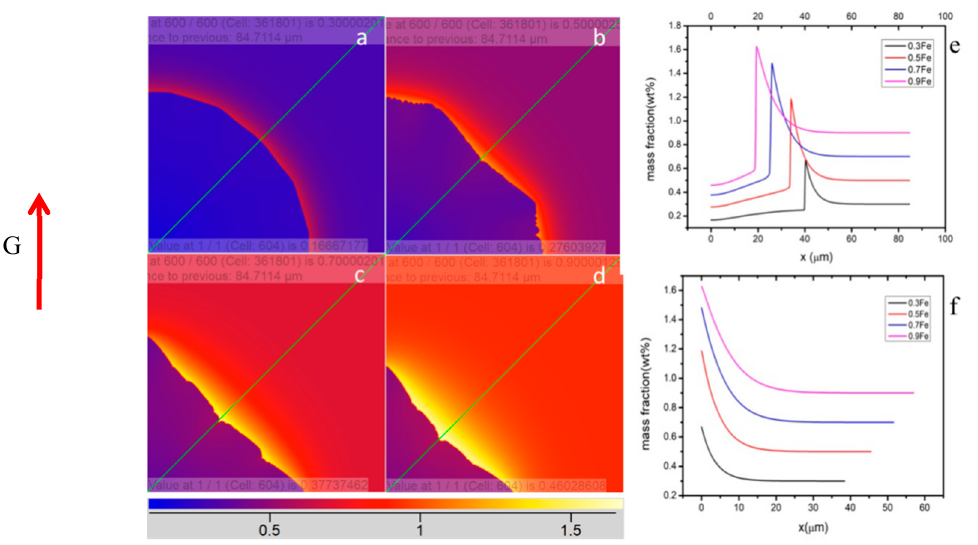
R was 4.01, 4.15, 4.00, and 3.54,